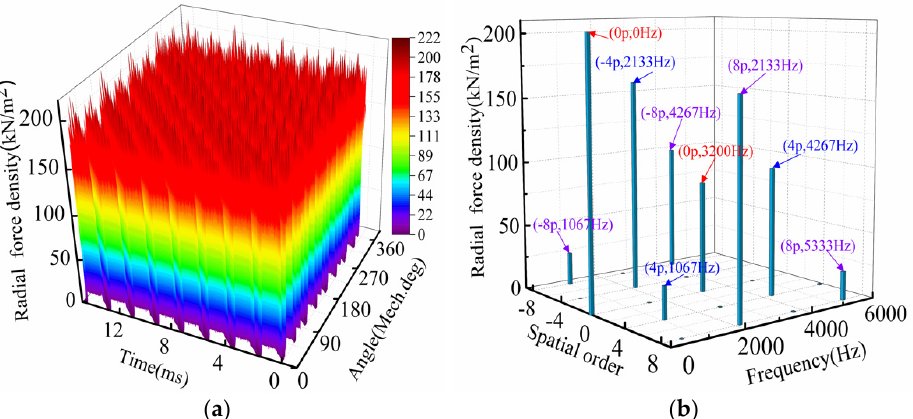
Figure 2. Radial force density distribution of stator teeth.